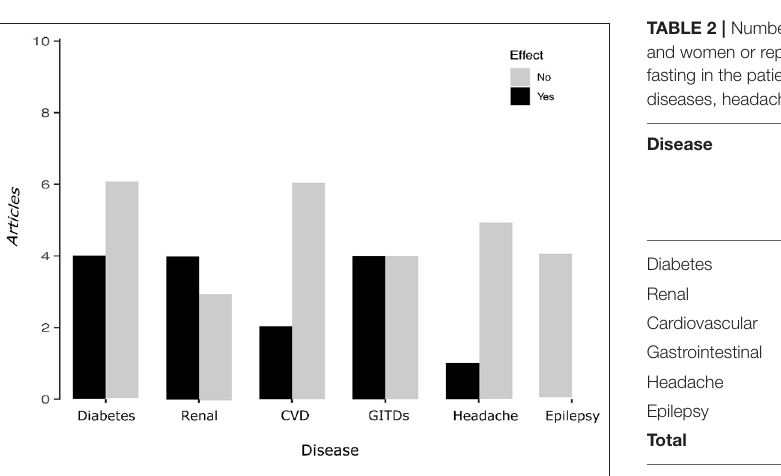
FIGURE 2 | The Bar-plot summarizes the results obtained from studies analyzed and shows the articles that reported sex-related changes during Ramadan.